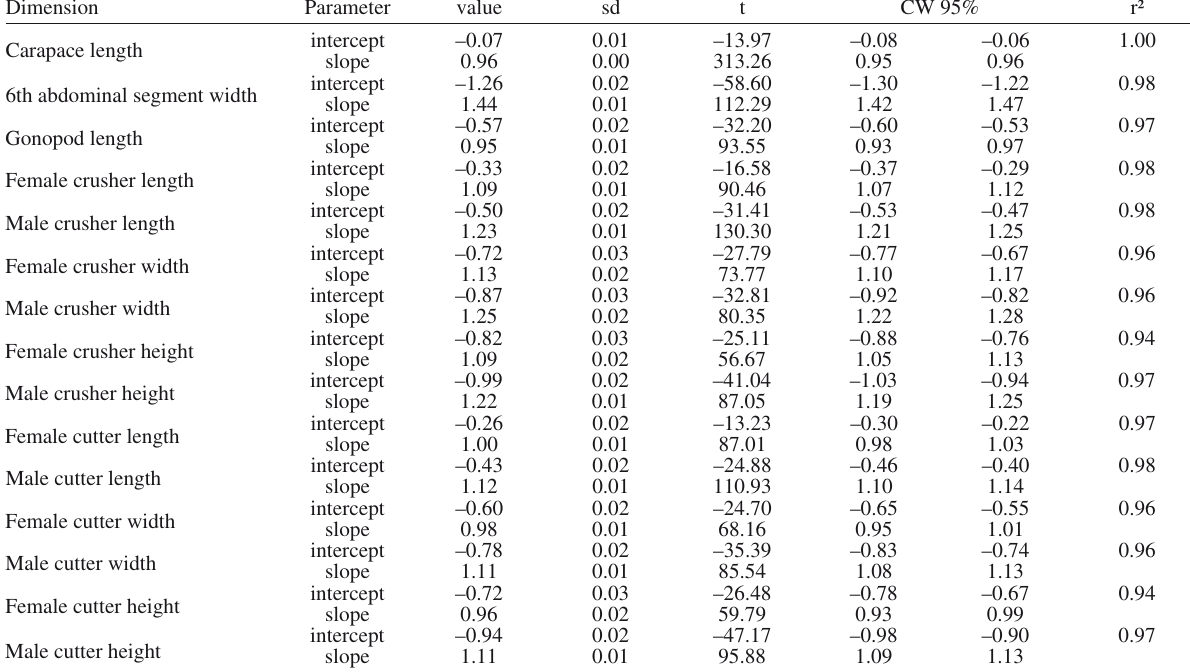
Table 1. – Allometric growth in Platyxanthus crenulatus. Estimated parameters for allometric equations (i.e. simple linear regressions applied to log-log transformed data) of different body parts of both sexes. Slopes are the “constants of relative growth” of each body part. Dimension